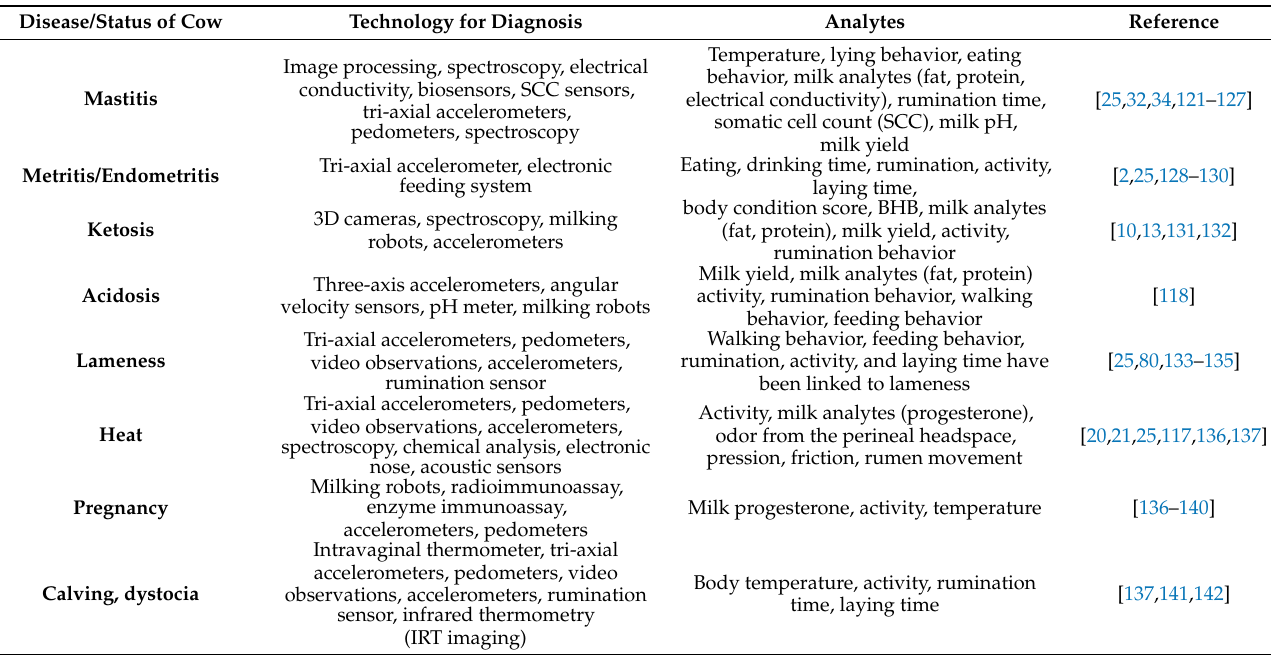
Table 5. Technologies for animal status